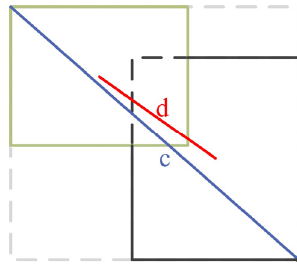
Figure 2. Target frame distance diagram. c represents the diagonal distance of the smallest closed area which contains both the predicted bounding box and the ground truth. d represents the distance in Euclidean space between the predicted bounding box’s center point and the ground truth’s center point.